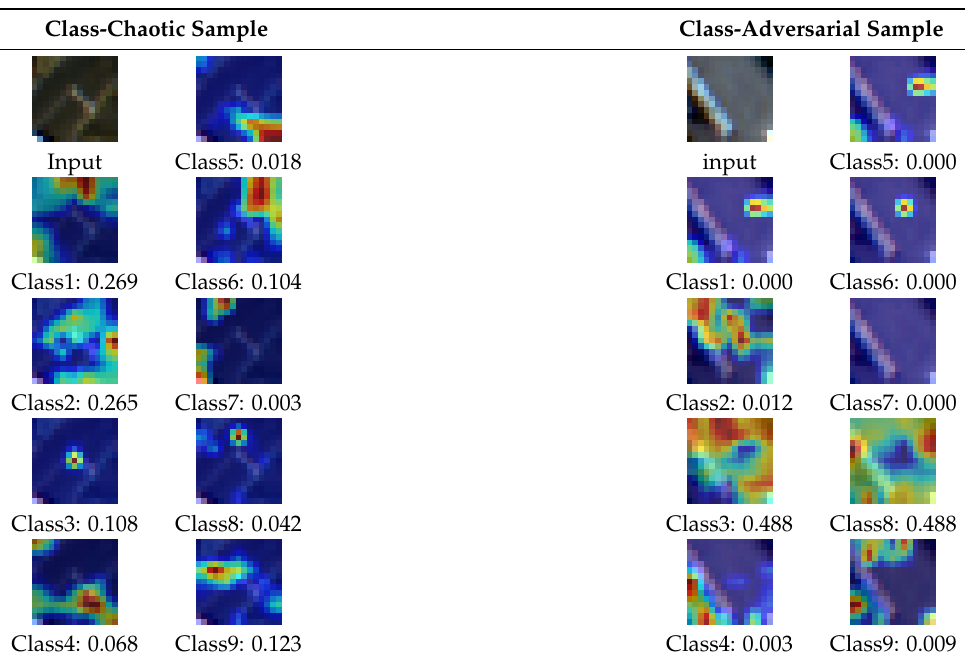
Table 3. The classification probability obtained by DLSN for class-chaotic and class-adversarial samples (considering PaviaU dataset as an instance).